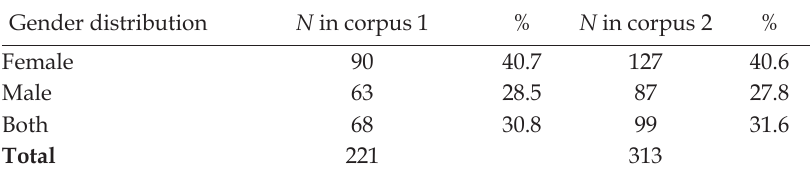
Table 3. Gender distribution in